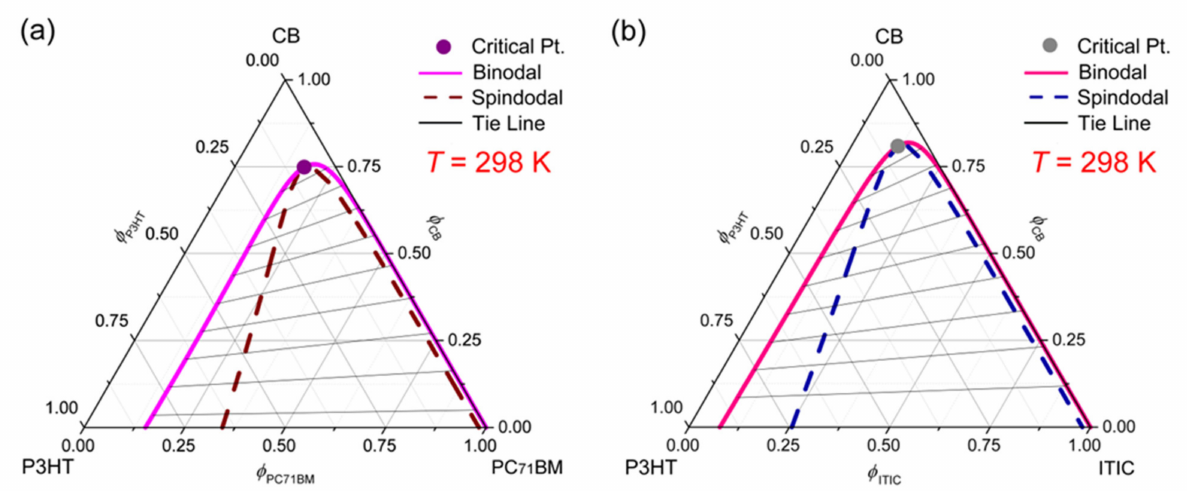
Figure 7. Phase diagrams for ternary systems at constant T = 298 K. ( a ) CB/P3HT/PC 71 BM: χ 12 = 0.45, χ 13 = 0.84, χ 23 = 1.41, s = 0.005071 and r = 0.147613. ( b ) CB/P3HT/ITIC: χ 12 = 0.45, χ 13 = 1.25, χ 23 = 1.99, s = 0.005071 and r = 0.071015.